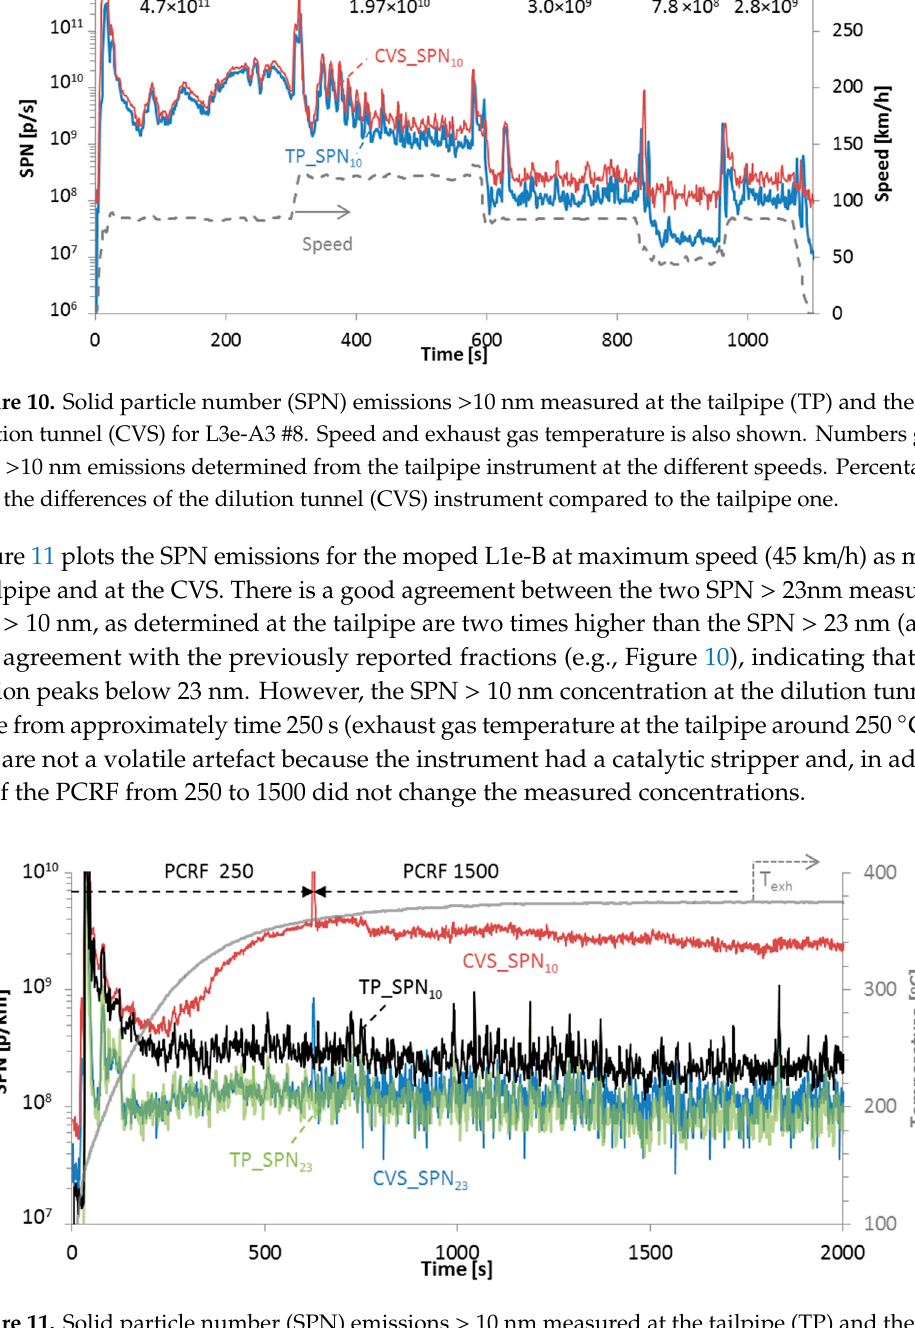
Figure 11. Solid particle number (SPN) emissions > 10 nm measured at the tailpipe (TP) and the full dilution tunnel (CVS) for the moped L1e-B. The particle number concentration reduction factor (PCRF) changed from 250 to 1500 at 600 s. Speed and exhaust gas temperature is also shown. The measurement system had a catalytic stripper.